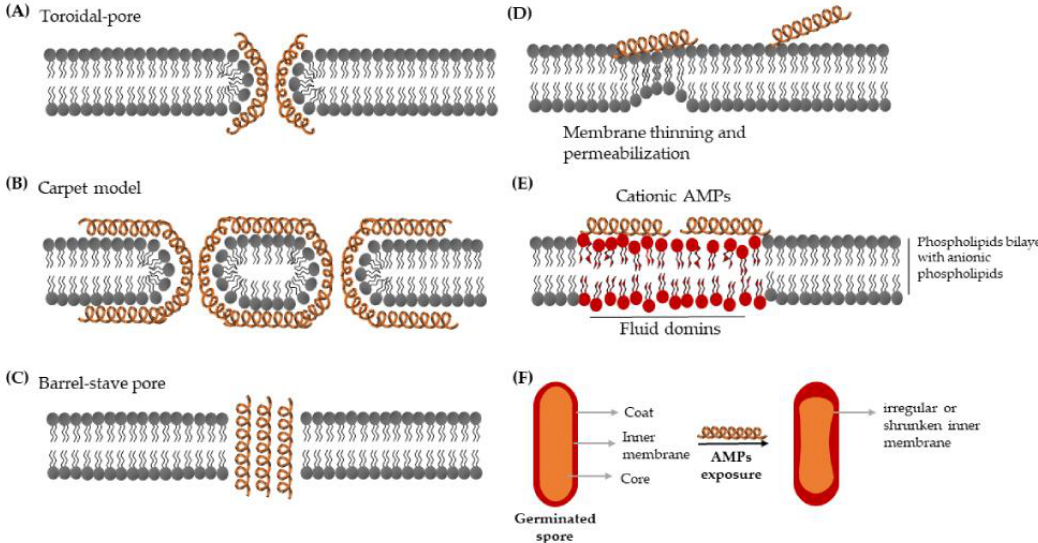
Figure 6. Various schematic models of antimicrobial peptides (AMPs) induced membrane disturbance. Models ( A – C ) are derived from in vitro membrane lipid model studies [123–125], and models ( D – F ) are based on single cell live-imaging studies [126–128]. See the manuscript text for a detailed explanation of each model.